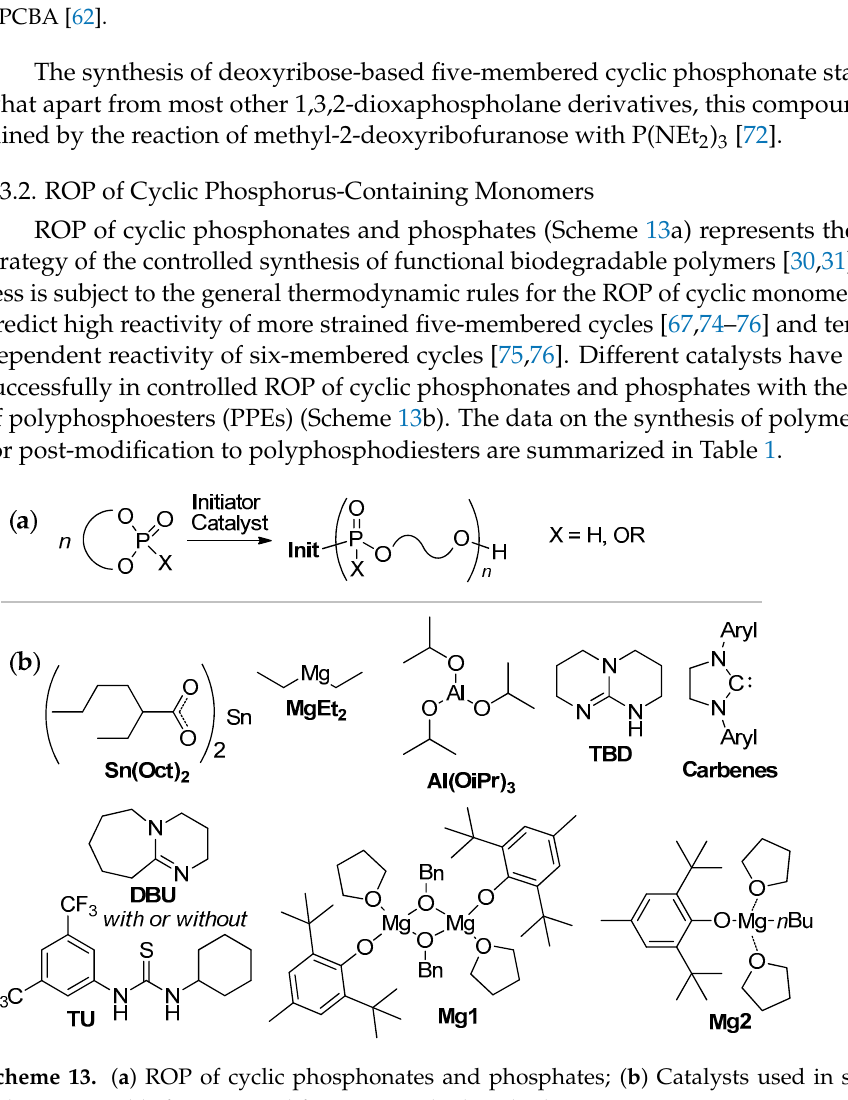
Table 1. Synthesis of polyphosphonates and polyphosphates suitable for post-modification with a formation of PCPAs. The structures of the catalysts are presented in Scheme